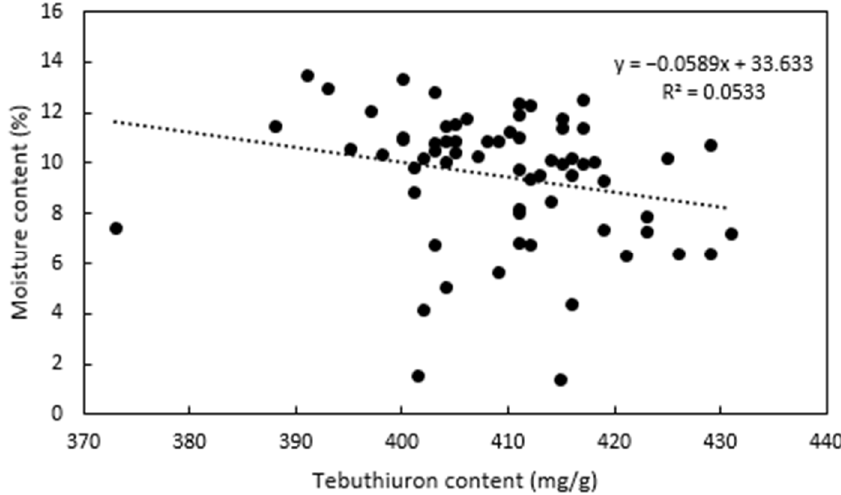
Figure 6. Relationship between the tebuthiuron content and the moisture content of the Regain400 samples.